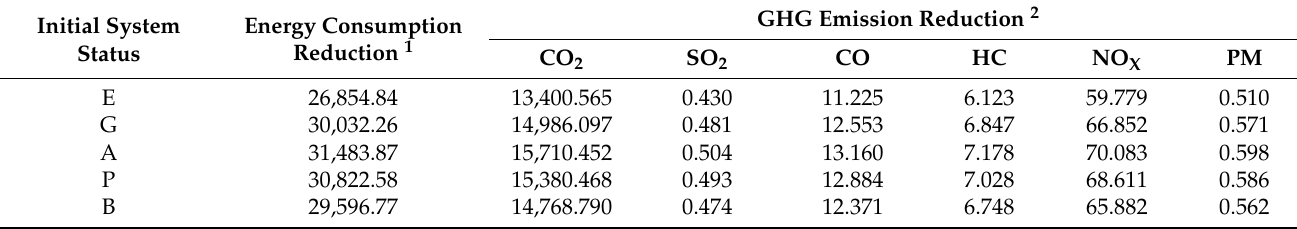
Table 10. Energy consumption reduction and GHG emission reduction resulting from the first iteration of maintenance policy optimization within the whole time-window of analysis in the case of natural gas electricity generation source. Initial